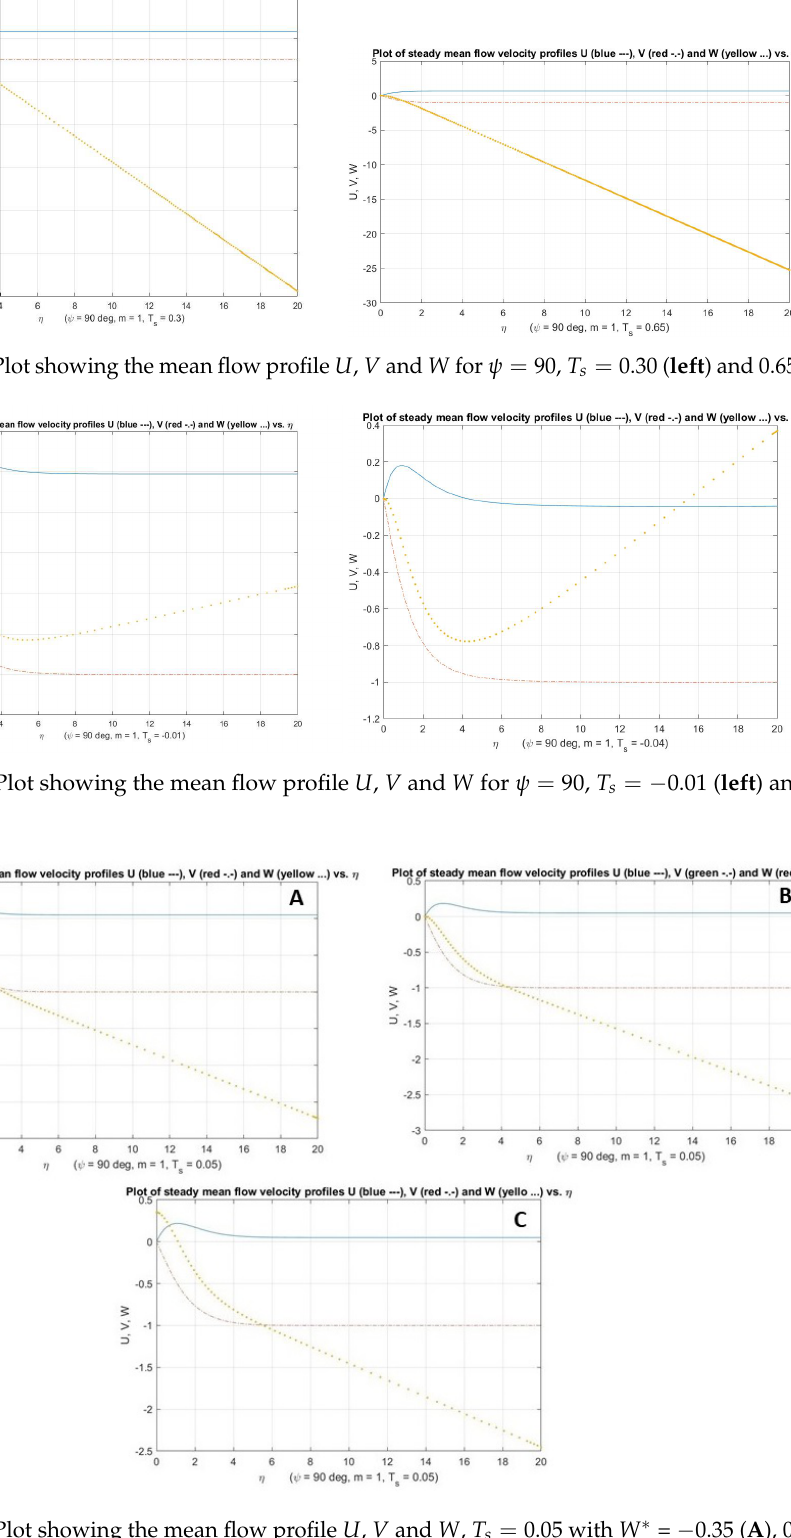
Figure 4. Plot showing the mean flow profile U , V and W , T s = 0.05 with W ∗ = − 0.35 ( A ), 0 ( B ) and 0.35 ( C